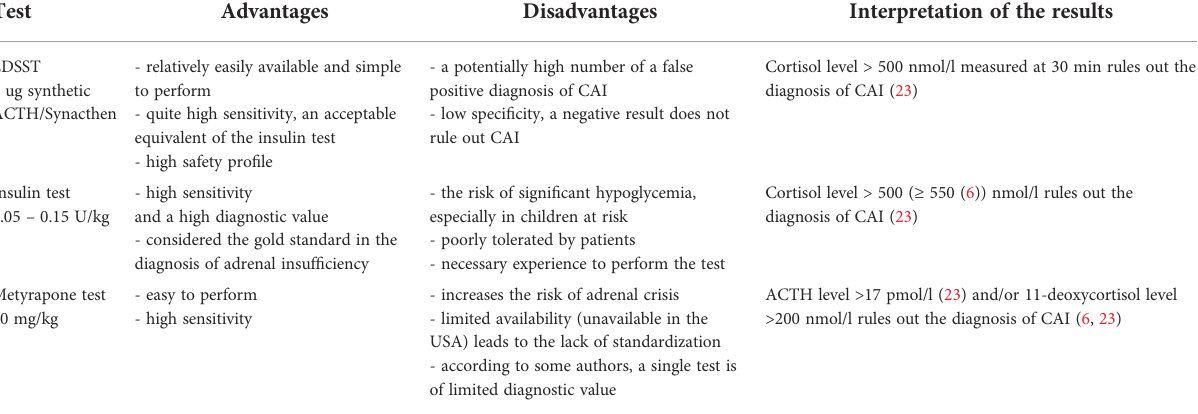
TABLE 2 All stimulation tests used to diagnose central adrenal insuf fi ciency in children (6, 22). Test Advantages